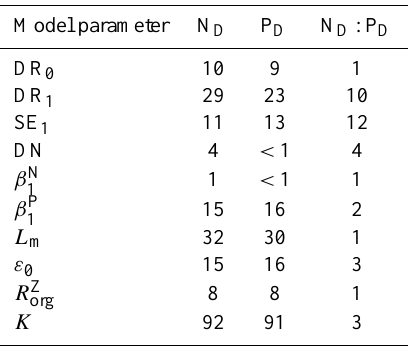
Table 3. Sensitivity of the deep nutrient concentrations to model parameters. Values represent the mean sensitivity index (SI, %) as a percentage of variation of model solutions compared to the standard simulation when a parameter has been decreased by 50%. See text for details on the calculation of SI. Model